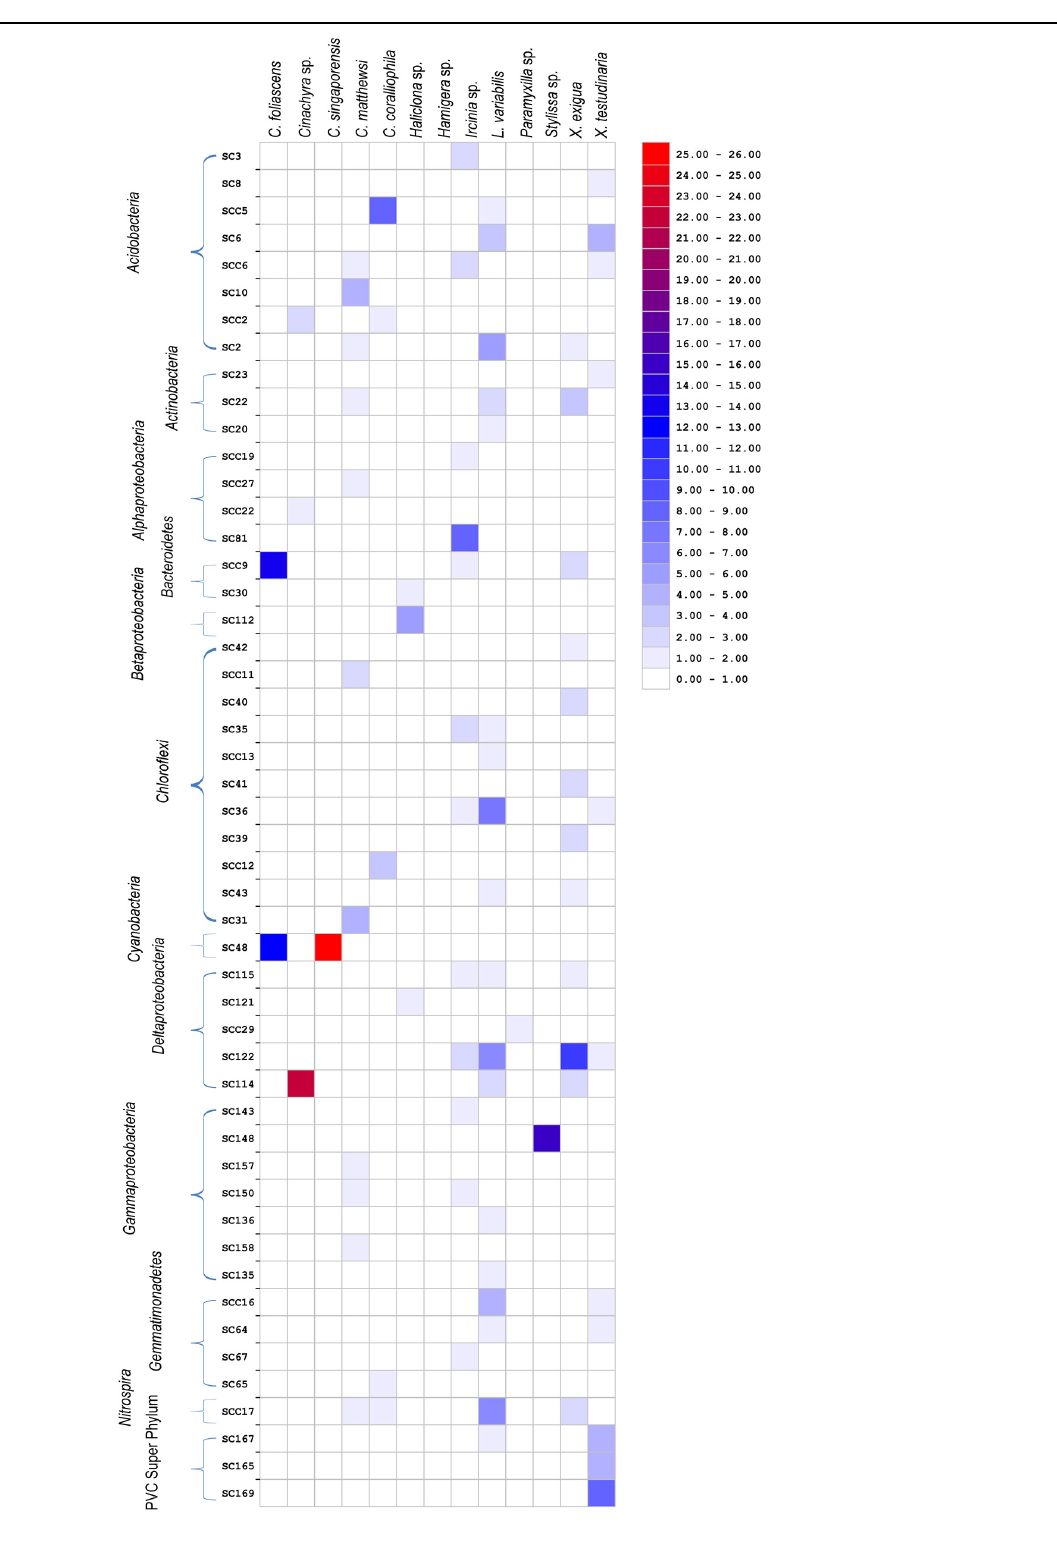
previously reported only from sponges; SCC prefix signifies clusters containing only sponge- and coral-derived sequences. Units are the percentage of total sequences from each sponge species that fall within